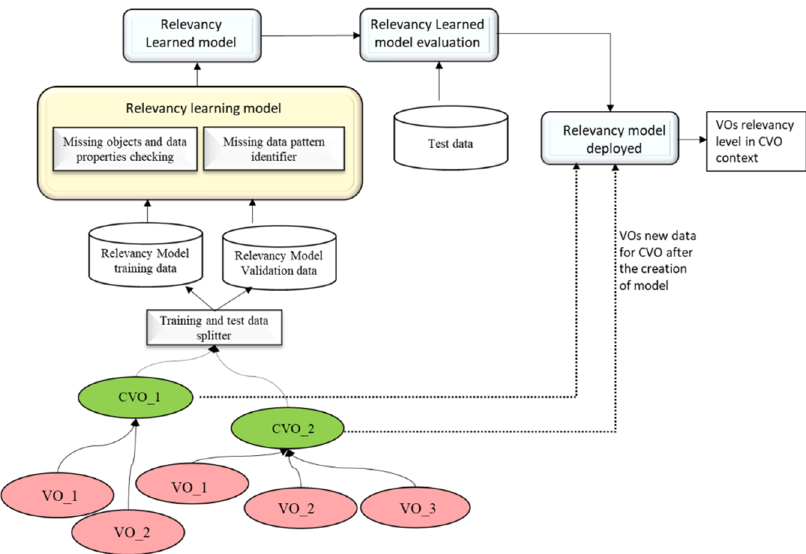
Figure 10. Relevancy metric learning mechanism.